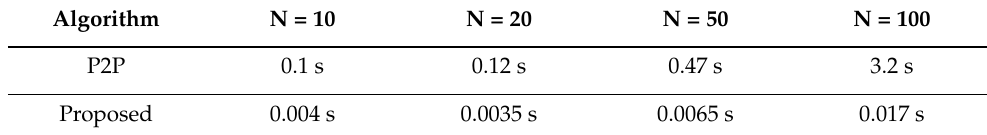
Table 4. Computational performance of the P2P and proposed algorithm.